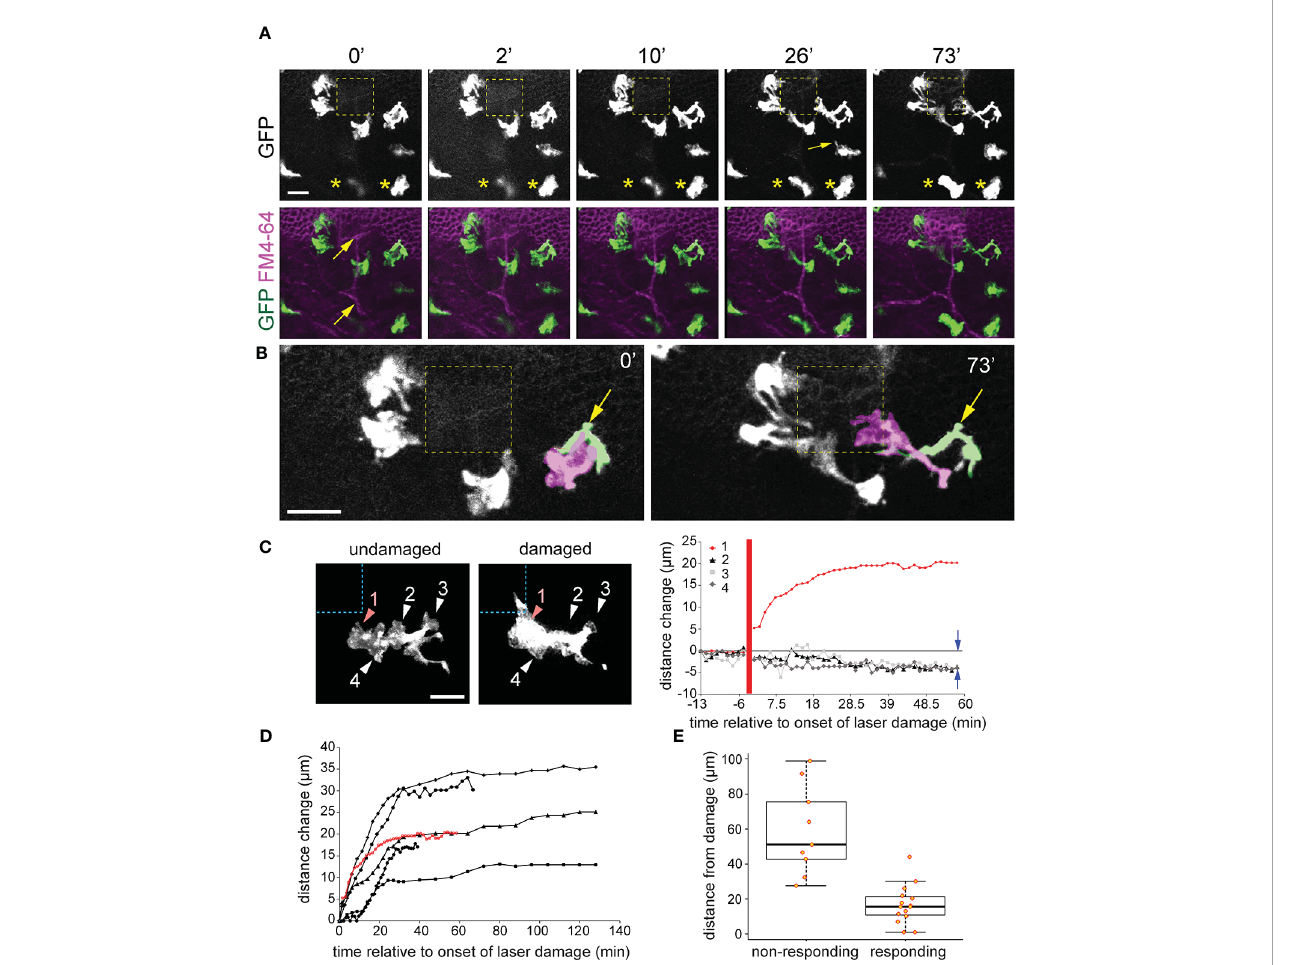
FIGURE 6 Cx3cr1 :GFP+ macrophage response to basal epithelial microdamage. (A) When nearby FM4-64 labelled basal epithelium is damaged using high power confocal laser scanning, Cx3cr1 :GFP+ macrophages project pseudopodia-like processes toward the damaged region (yellow dashed square). Times represent minutes after offset of high-powered laser exposure. The panel directly below (A) is a maximum intensity project along the z axis showing labelling of GFP (green) and FM4-64 (magenta). Yellow arrows indicate anterior stromal nerve fi bers. (B) Zoomed-in regions from (A) at times 0 ’ and 73 ’ . Two overlapping GFP+ cells, one a macrophage (shaded magenta) and the other a dendritic cell (shaded green and labeled with yellow arrow) de fi ned by its long and slender morphology are observed. By 73 ’ , the blue macrophage becomes highly polarized and projects to the damaged region while the green dendritic cell only extends slightly toward the damaged region. The remaining cells in (B) are all macrophages. (C) Imaging of a single macrophage before and after basal cell microdamage (indicated by the blue dashed box). The distance change over time of pseudopodia-like processes #1-4 is plotted on the right. Positive values indicate a change in length away from the cell and negative values indicate retraction. Data from the macrophage shown in (A) reveals that the pseudopodia closest to the damaged area (process 1) reached full extension after 30 minutes, and pseudopodia #2-4 which were further away from the microdamage retracted by approximately 5 µm as indicated by the blue arrows in the graph. The thick vertical red line indicates the time of injury. (D) Similar plot as in (C) showing the change in length of pseudopodia-like projections from six different macrophages that exhibited a response to epithelial microdamage. (E) Graph showing distance of “ responding ” and “ non-responding ” macrophages (see Methods for description) from the damage site; 16.8 ± 11.1 µm (responding) vs. 59.0 ± 25.3 µm (non-responding), P < 0.01, two tailed unpaired T test, n = 4 mice). Scale bar = 20 µm (A, C) , 30 µm (B)